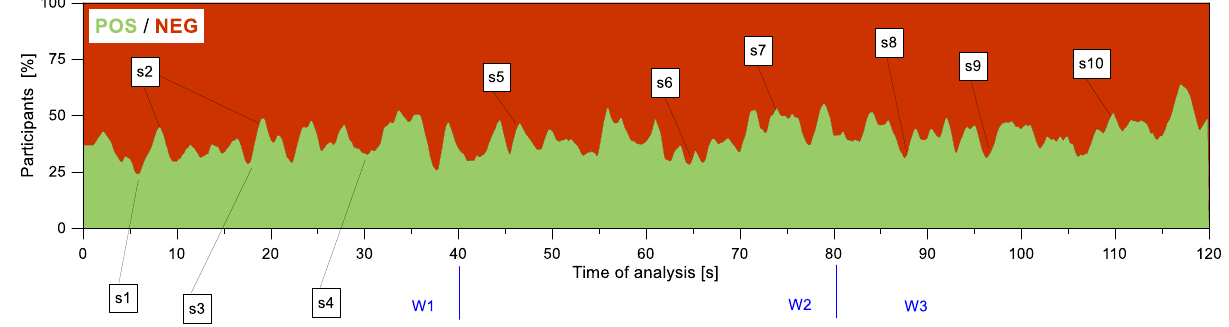
Figure 19. Detection of prevailing reactions (in percentage values for the group of participants), as a function of the time of analysis for the dynamic VR scenario.